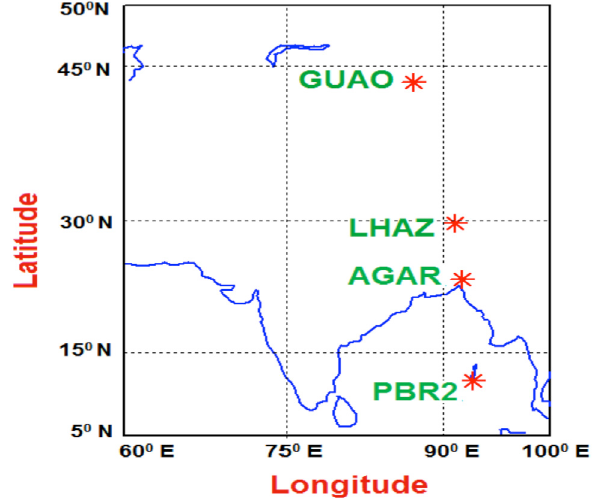
Figure 1. Map showing the geographic location of GPS stations, used in the present study. The geomagnetic latitudes of PBR2, AGAR, LHAZ and GUAM stations respectively are 2.11°N, 14.22°N, 20.09°N and